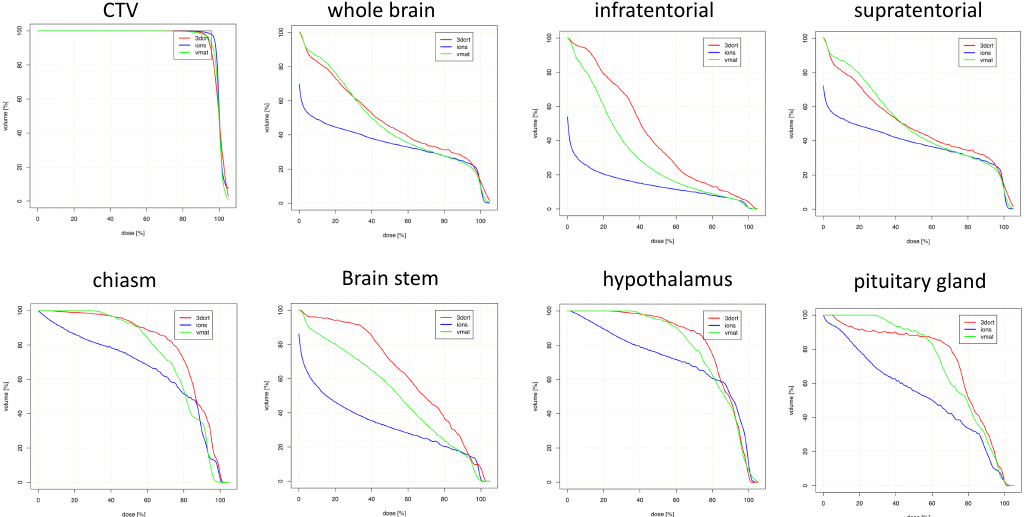
Figure 3. Dosimetric comparison: clinical target volume coverage and dose volume histogram curves of the organs-at-risk in patients with temporal tumor localization. Curves demonstrate median dose values of all patients with temporal tumor localization. Intensity-modulated proton therapy (IMPT/PRT; blue line) vs. volumetric-modulated arc therapy (VMAT; green line) vs. three-dimensional conformal radiotherapy (3DCRT; red line). CTV: clinical target volume.